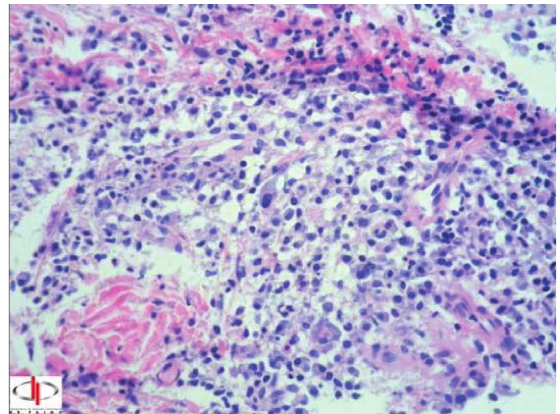
Figure 5: Result of the histopathological examination conducted by the Laboratory of Pathological Anatomy, Dr. Paino: ulcerative inflammatory process with lymph-plasmacytic predominance and possible leishmaniasis with etiological agent not demonstrable by the method of hematoxylin and eosin or giemsa (hyperallergic reaction?). A close clinical-epidemiological correlation is necessary, as well as with Montenegro intradermal reaction. Note: there is no evidence of malignancy.